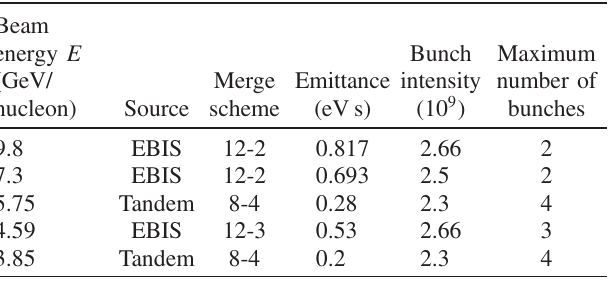
GOLD-GOLD LUMINOSITY INCREASE IN RHIC TABLE III. Longitudinal emittances and bunch intensities at AGS extraction for the five BES-II energies. The “ Merge scheme ” column records the rf gymnastics bunch merging scheme used in the AGS to increase the number of particles per bunch. The longitudinal “ Emittance ” is the 95% emittance, 6 times the rms emittance. The maximum number of bunches that could be extracted during each AGS cycle varied from 2 to 4.